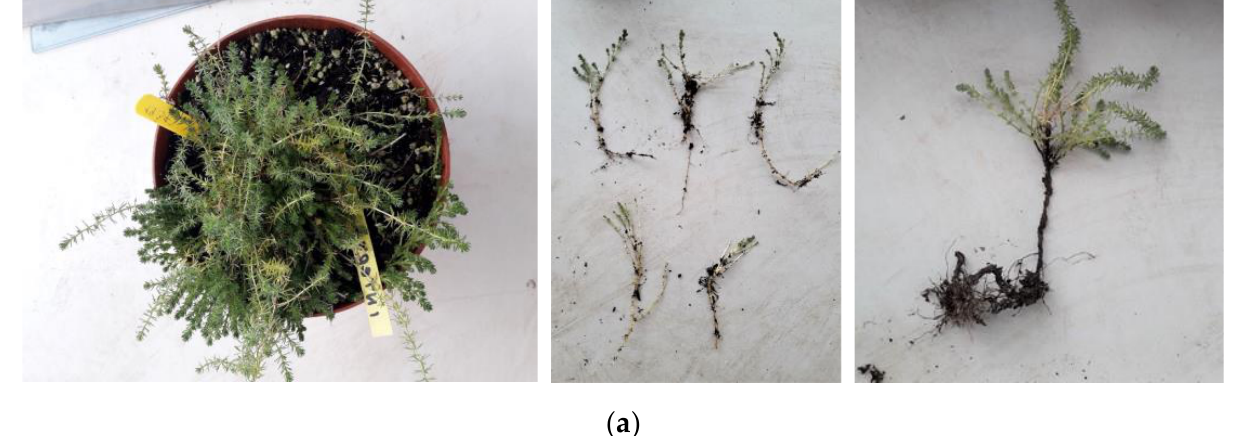
Figure 5. Representative photos of asexual propagation via cuttings (cutting preparation from mother plants, rooted cuttings, transplanted young individuals) of wild-growing plants in different conservation priority categories. ( a ) Priority A1 taxon Thymus oehmianus (Lamiaceae) with accession number 19,365; ( b ) Priority B4 taxon Betonica scardica with accession number 19,451; ( c ) Priority C3 taxon Cerastium rectum subsp. petricola with accession number 19,493.